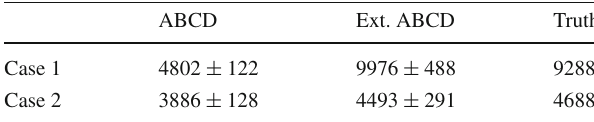
Table 4 Predictions of entries in region D for the two cases in Table 3.